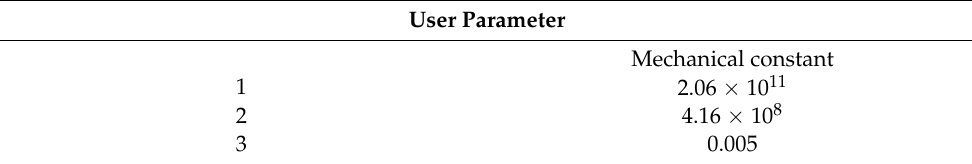
Table 2. iSteel01 material